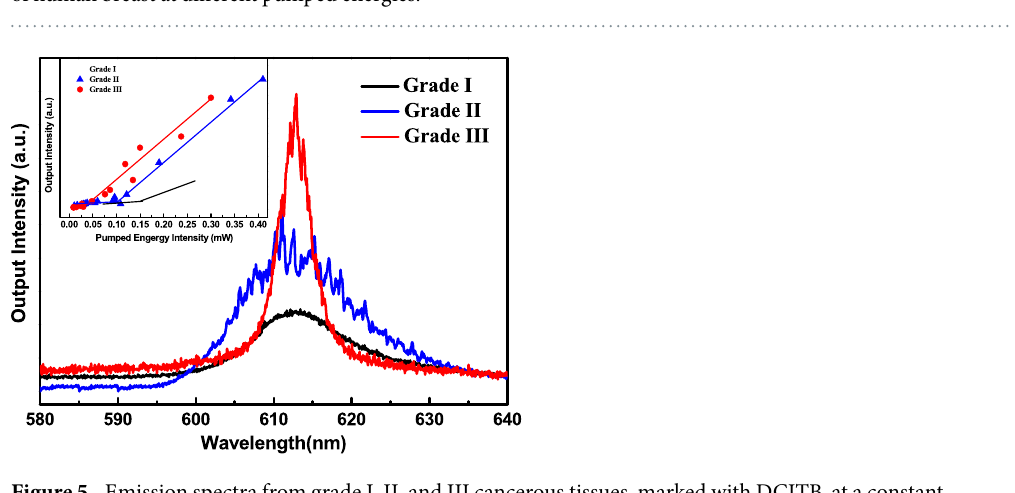
Figure 4. Emission spectra from the nanotextured DCJTB embedded in ( a ) healthy and ( b ) cancerous tissues of human breast at different pumped energies.